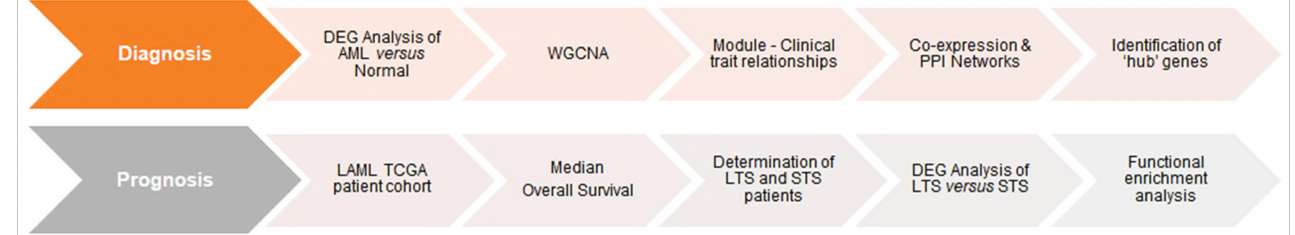
Figure 1. Flowchart diagram of the methodology employed in this